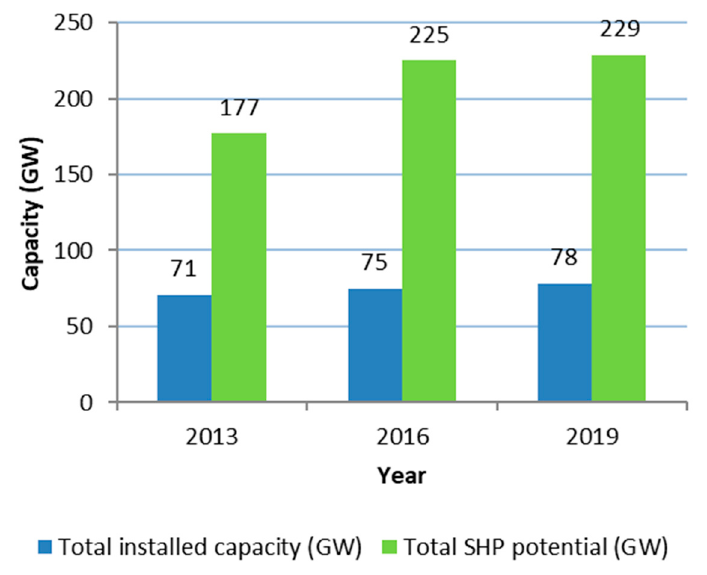
Figure 1. Worldwide SHP installed vs. potential capacity [24].